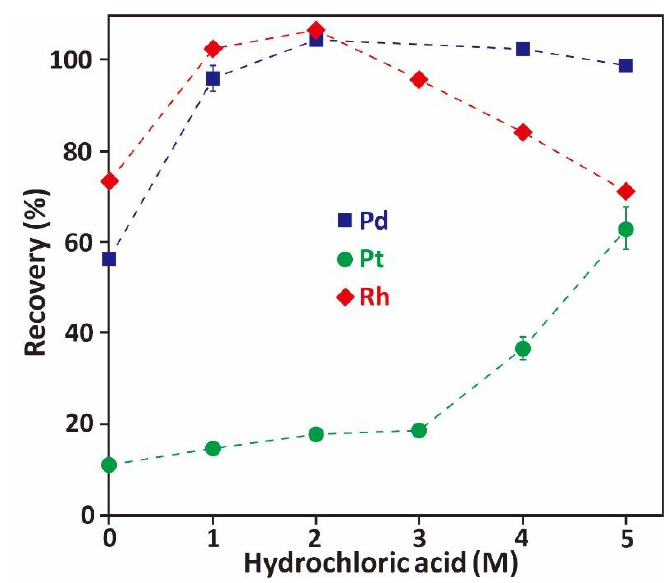
Figure 8. The effect of hydrochloric acid concentration as a lixiviant on the PGE